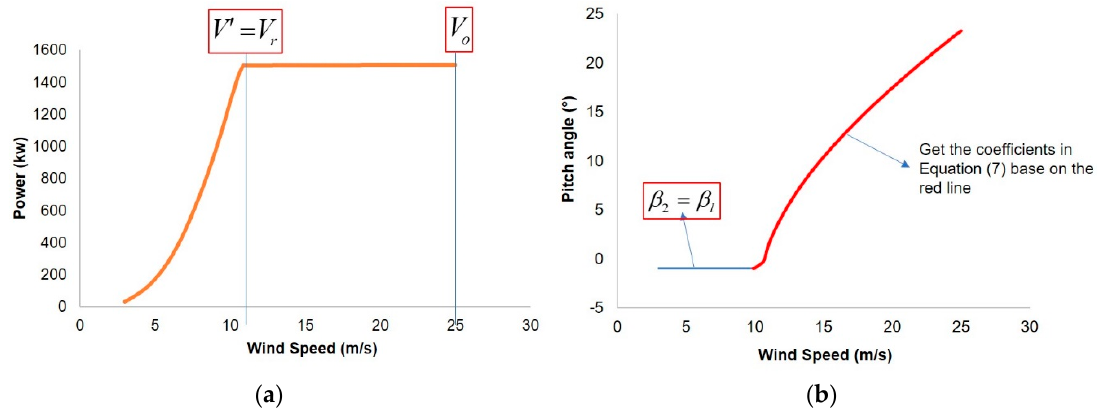
Figure 4. ( a ) Power and ( b ) pitch angle changing with wind speed in steady simulation.